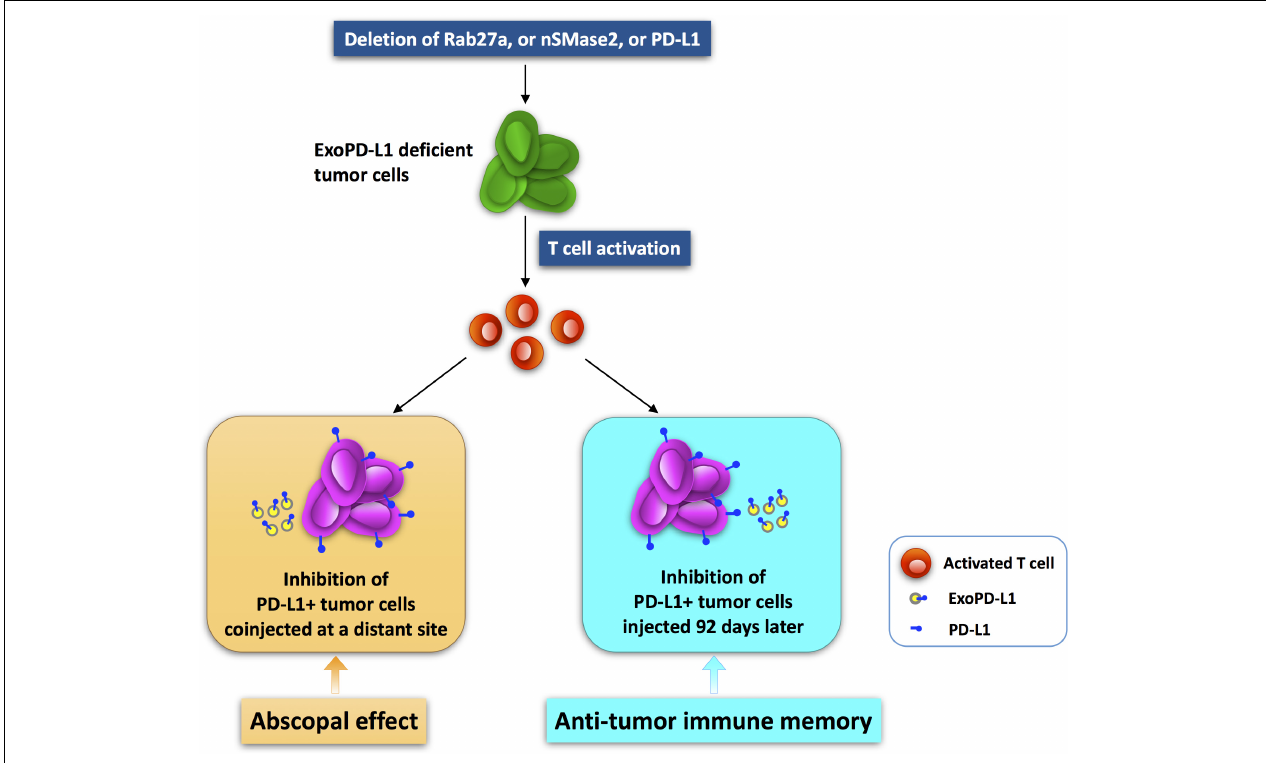
FIGURE 3 | The abscopal effect and antitumor immune memory induced by ExoPD-L1-deficient tumor cells. Tumor cells with ExoPD-L1 deletion are generated by genetic mutation of Rab27a, nSMase2, or PD-L1. The growth of PD-L1-positive tumors at a distant site is inhibited when ExoPD-L1-deleted tumor cells are coinjected simultaneously. In addition, the growth of PD-L1-positive tumors injected secondarily 92 days later is also suppressed.